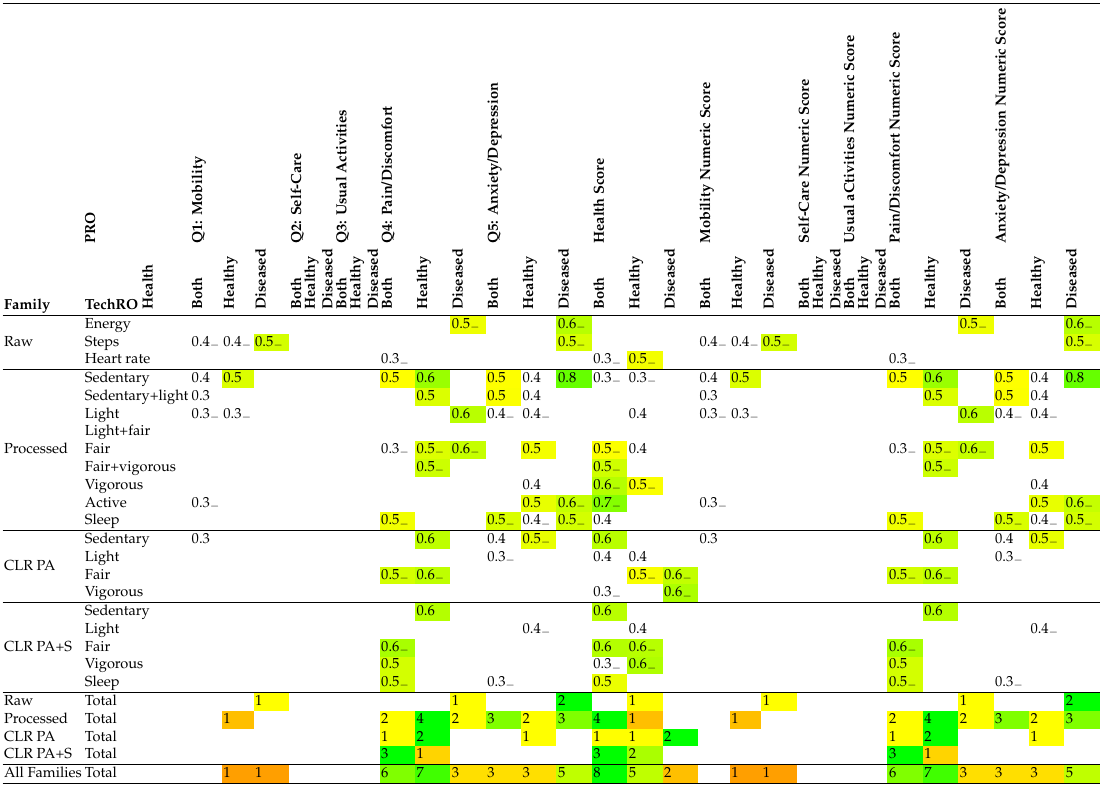
Table A20. Correlation coefficient (Spearman r S ) between TechROs from Fitbit (rows) and PROs of Health-Related Quality of Life on the EQ-5D-3L scale (columns).